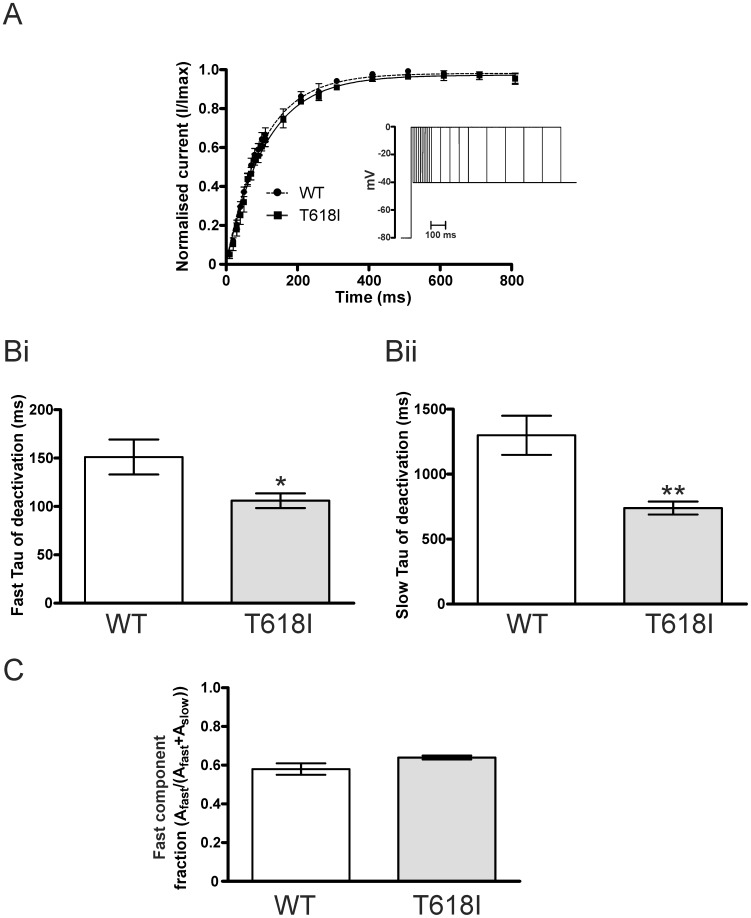
WT and T618I IhERG time-course of activation and deactivation.(A) Plots of time-course of IhERG activation obtained using an “envelope-of-tails” protocol– see inset and ‘Results’ text. For each cell, the peak current amplitudes at each time-point were normalized to the maximal current observed during the protocol. (Bi, Bii) Bar charts comparing τf (Bi) and τs (Bii) values for deactivation of WT (n = 11) and T618I (n = 11) hERG tail currents on repolarisation to -40 mV following a 2 s depolarisation from −80 mV to +20 mV. Currents were fitted with a standard bi-exponential equation (C) Bar-chart showing the proportion of fast deactivation on repolarisation to −40 mV for WT and T618I IhERG (n = 11 cells for each condition). Asterisks in Bi and Bii denote statistical significance: *p<0.05; **p<0.01.